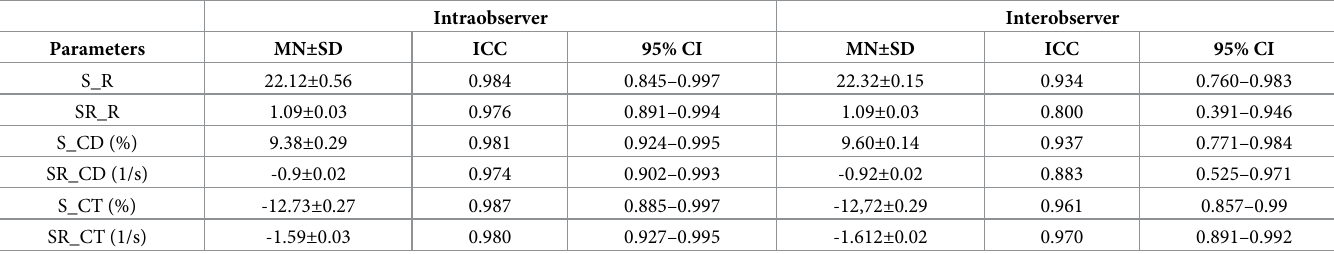
Table 8. Reproducibility of the LA strain parameters by